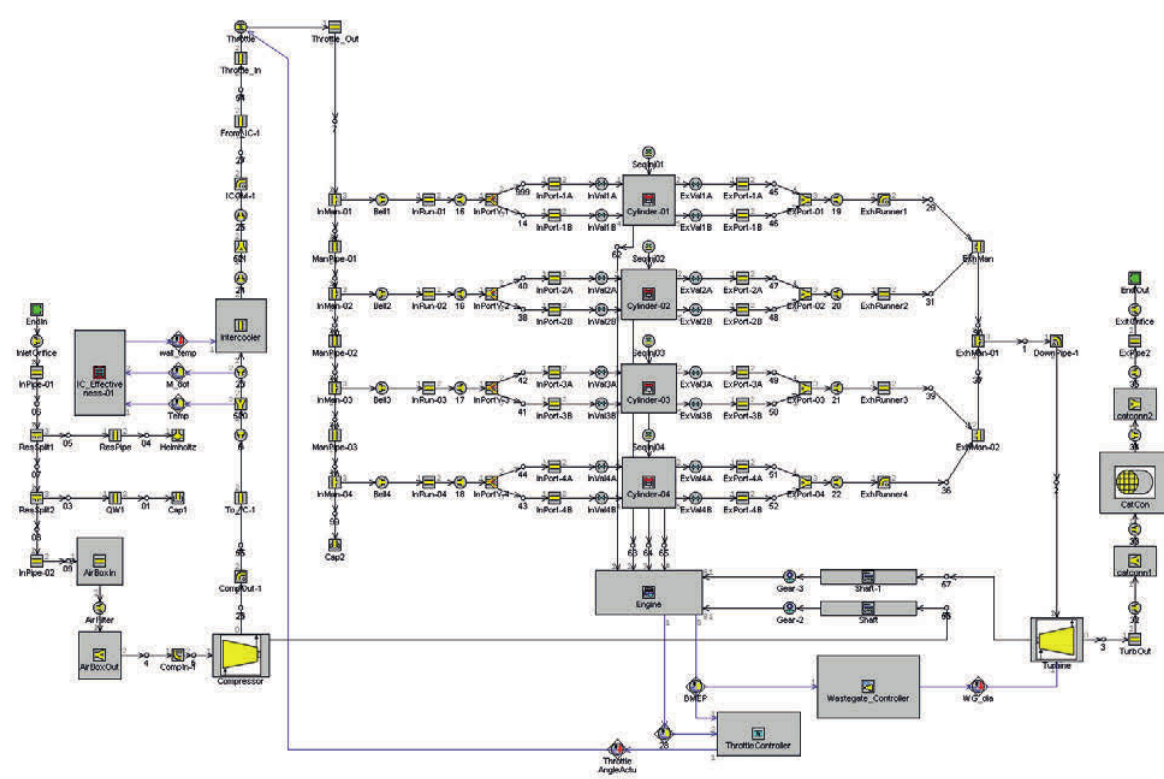
Fig. 3: Engine model